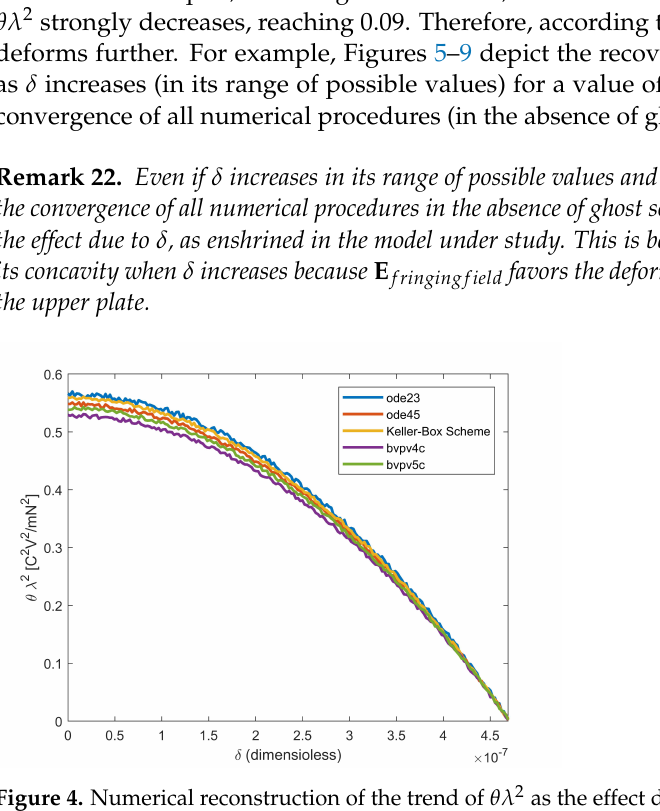
Figure 4. Numerical reconstruction of the trend of θλ 2 as the effect due to the fringing field increases (in convergence conditions and without ghost